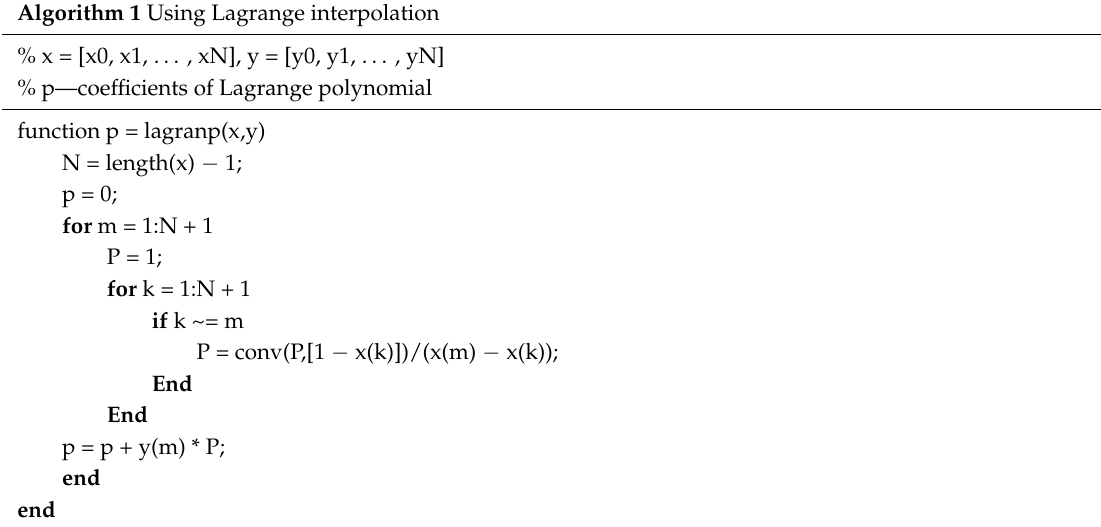
Algorithm 1 Using Lagrange